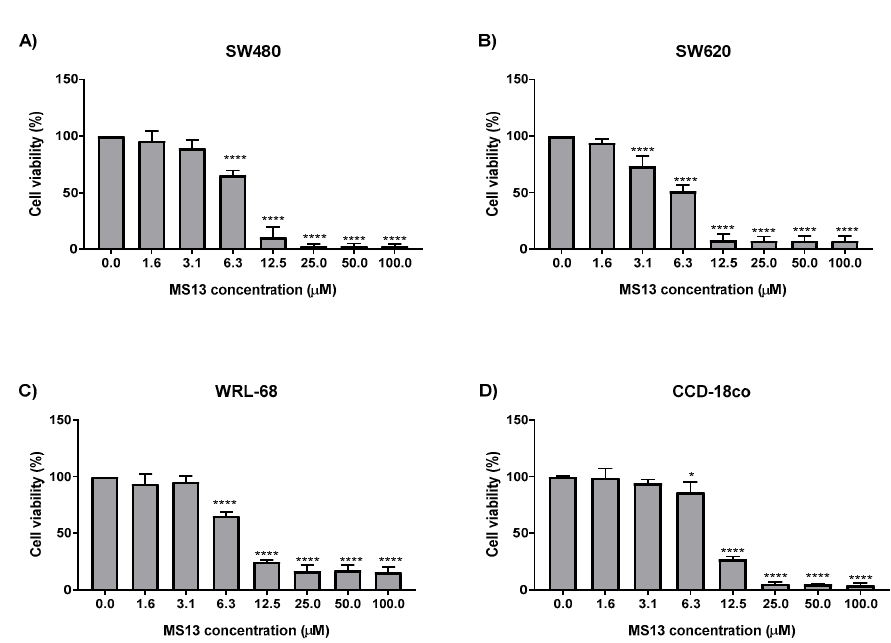
Figure 2. The cytotoxicity effect of MS13 on ( A ) SW480, ( B ) SW620, ( C ) WRL-68 and ( D ) CCD-18co cell viability. Experiments were performed in triplicates and results were compared between three independent experiments. Statistically significant differences between the means of values obtained with treated vs untreated are represented by * for p ≤ 0.05, ** for p ≤ 0.01, *** for p ≤ 0.001 and p **** for p ≤ 0.0001. Error bars indicate mean ± SEM.